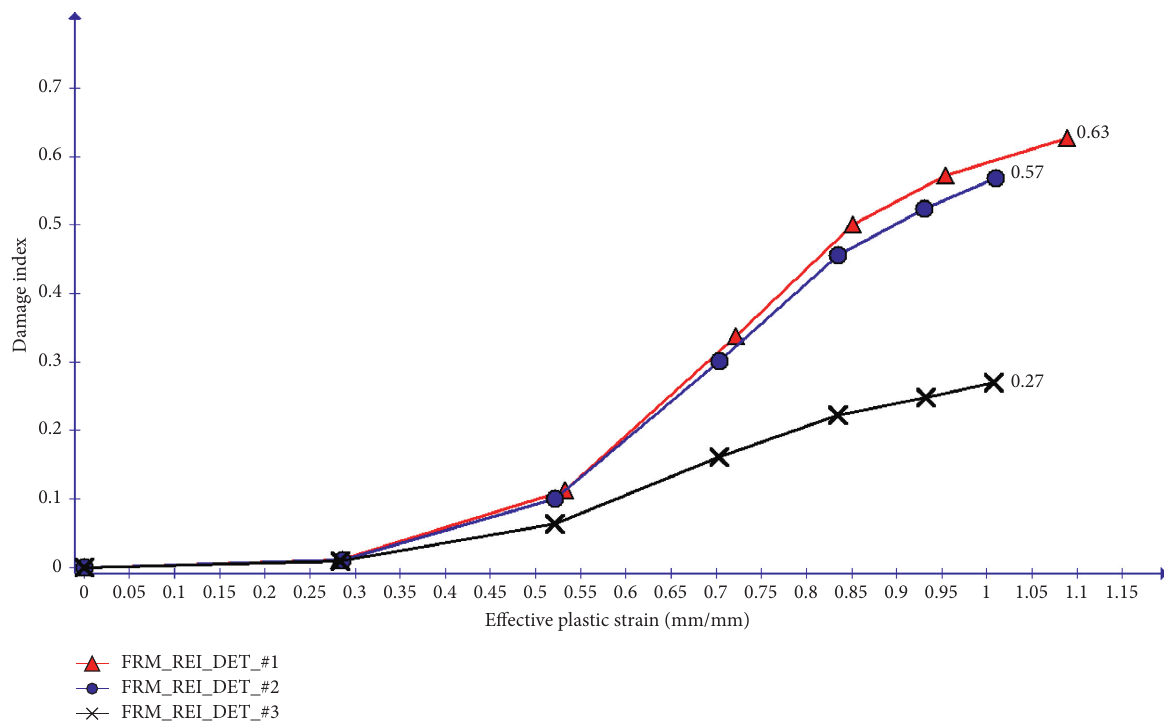
Figure 24: Column damage index vs. effective plastic strain plot for 215kg TNT explosive located at 2 nd story floor